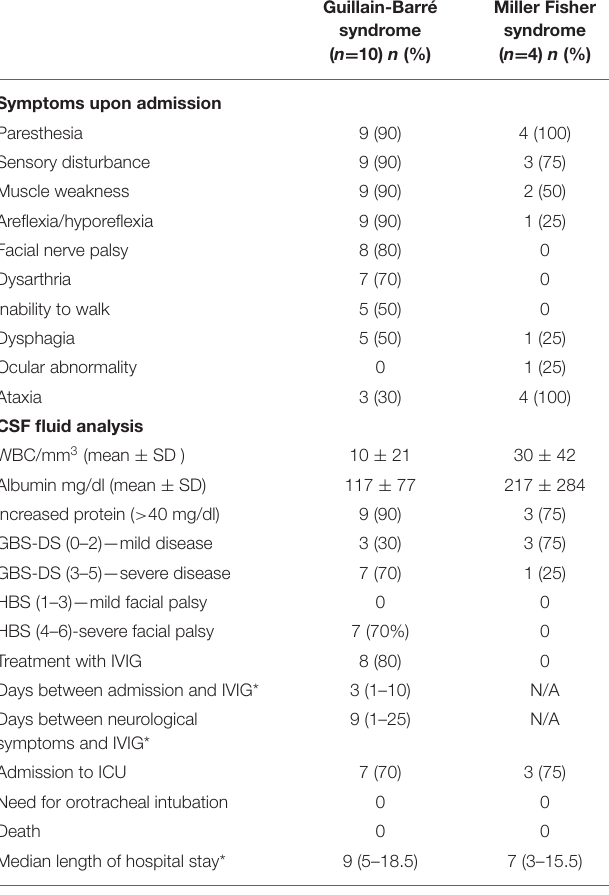
TABLE 2 | Neurological symptoms and clinical characteristics of 14 patients with Guillain-Barré syndrome or Miller Fisher syndrome in Salvador, Brazil. Guillain-Barré